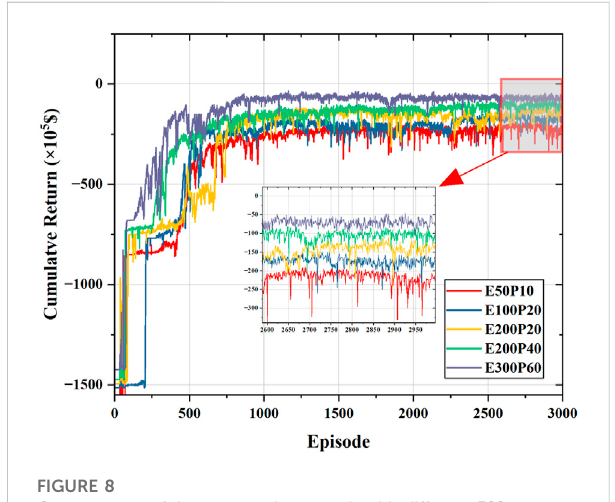
FIGURE 8 Convergence of the proposed approach with different ESS parameters.